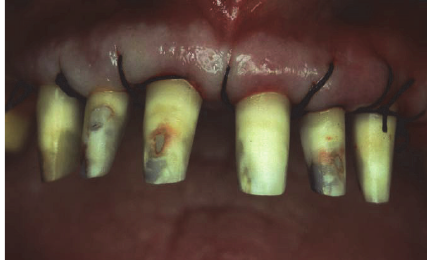
Figure 15: CT scan for evaluation of implant